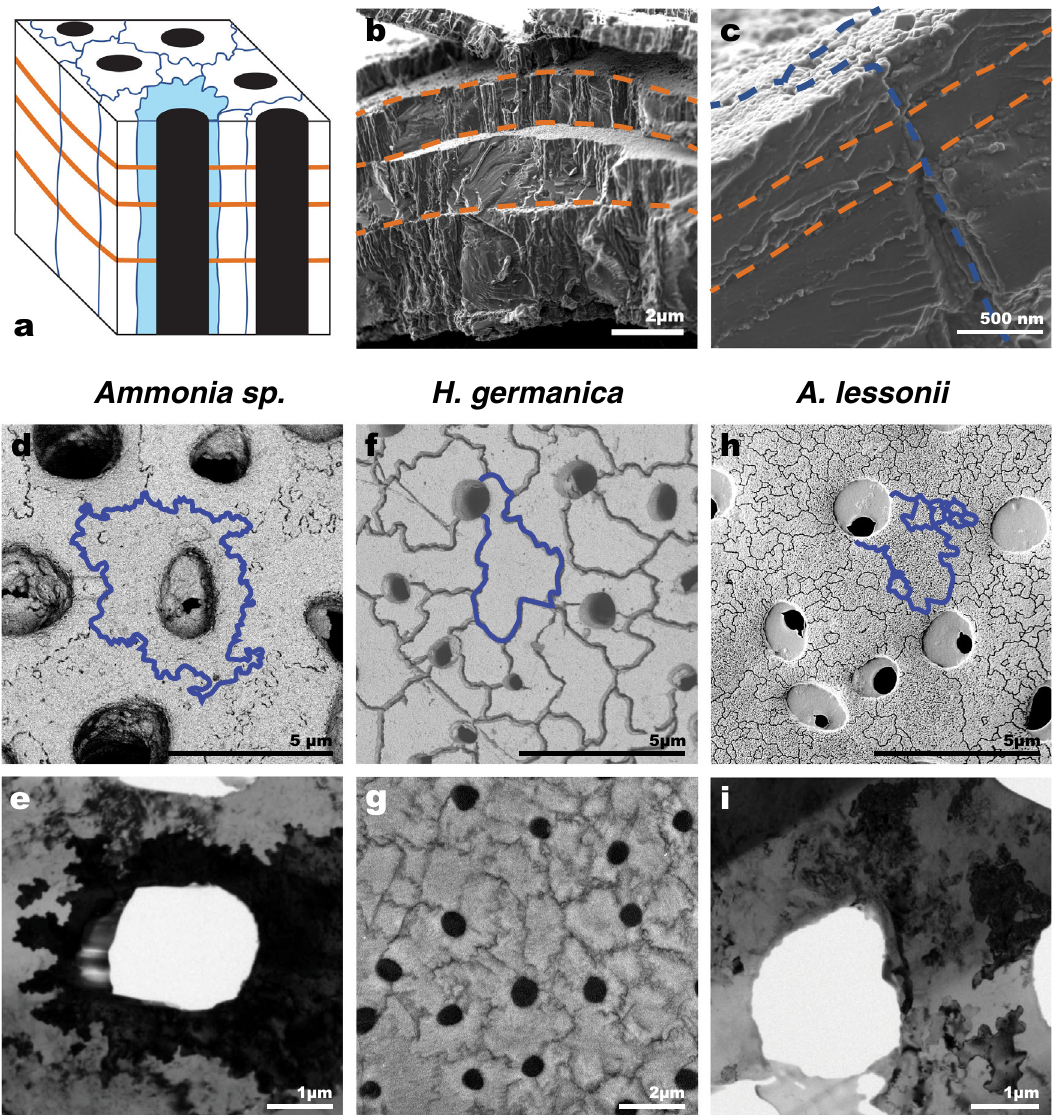
Fig. 2 Ultrastructural organization. Organic linings and cogwheel structures in Ammonia sp., H. germanica and A. lessonii . a Schematic diagram showing the spatial location of cogwheel structures and organic linings on the surface and inside benthic foraminifera test walls. Cogwheel interfaces are outlined in blue, a single cogwheel structure is shaded in light blue, pore-spaces are black, and organic linings are marked by orange lines. b SEM image of the edge of a broken Ammonia sp. test wall. The step-like fractures running parallel to the test surface (highlighted in orange hatched lines) correspond to the organic linings. c SEM image of the surface and interior of an Ammonia sp. test wall showing a cogwheel interface (outlined with dashed blue lines) extending throughout the thickness of the wall, perpendicularly to the organic linings (dashed orange lines). d SEM image of cogwheels on the surface of an